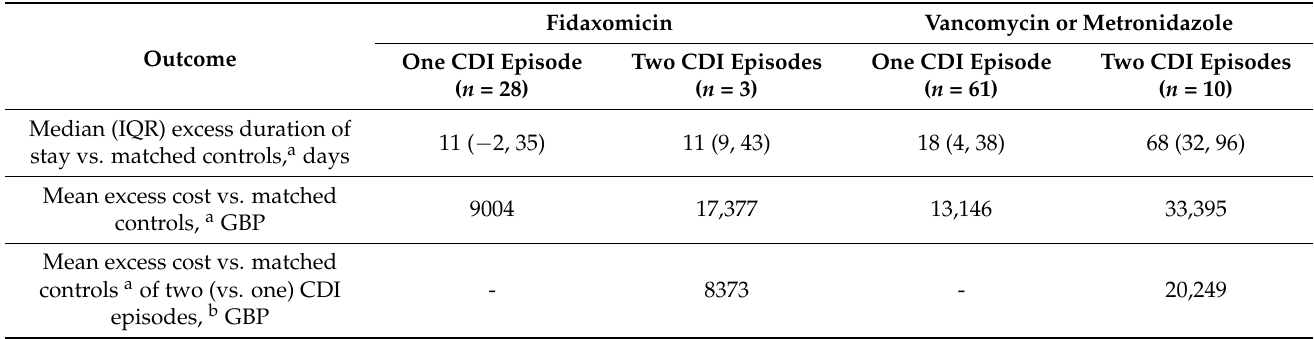
Table 4. Excess costs (vs. matched controls) of CDI episodes.